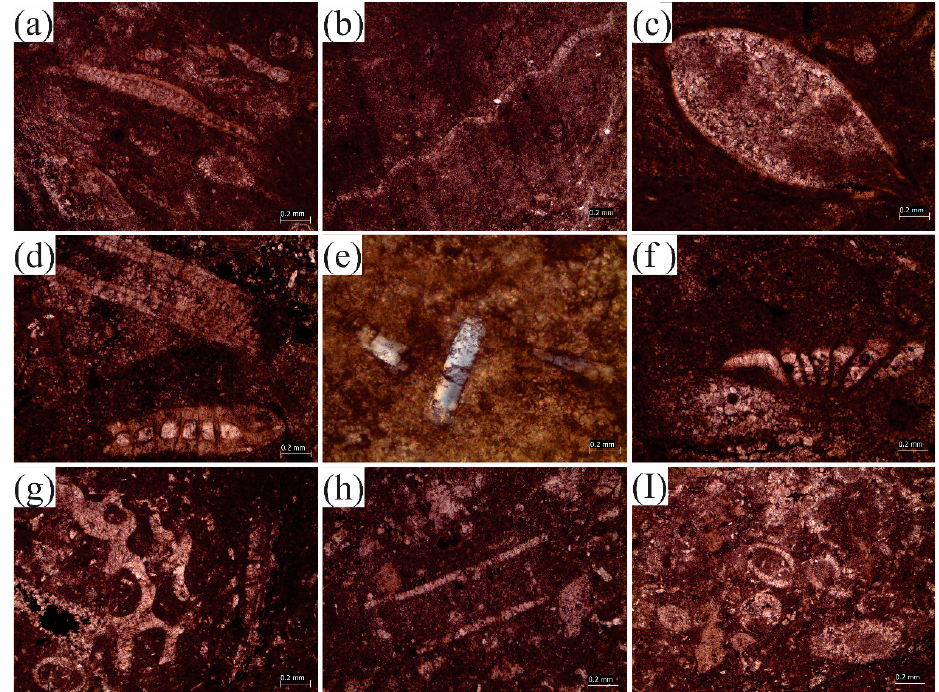
Figure 7. Photomicrographs showing ( a ) coralline algae and Idalina grelaudae (Middle Eocene mil- liolid); ( b ) filamentous shells of bivalves; ( c ) an ostracod; ( d ) Assilina spp.; ( e ) gypsum; ( f ) unidentified algal fossil; ( g ) algae; ( h ) Calcispheres green algae and Spatangoid spine algae; and ( I ) Dasycladacean green alga ( Cymopolia elongata ).